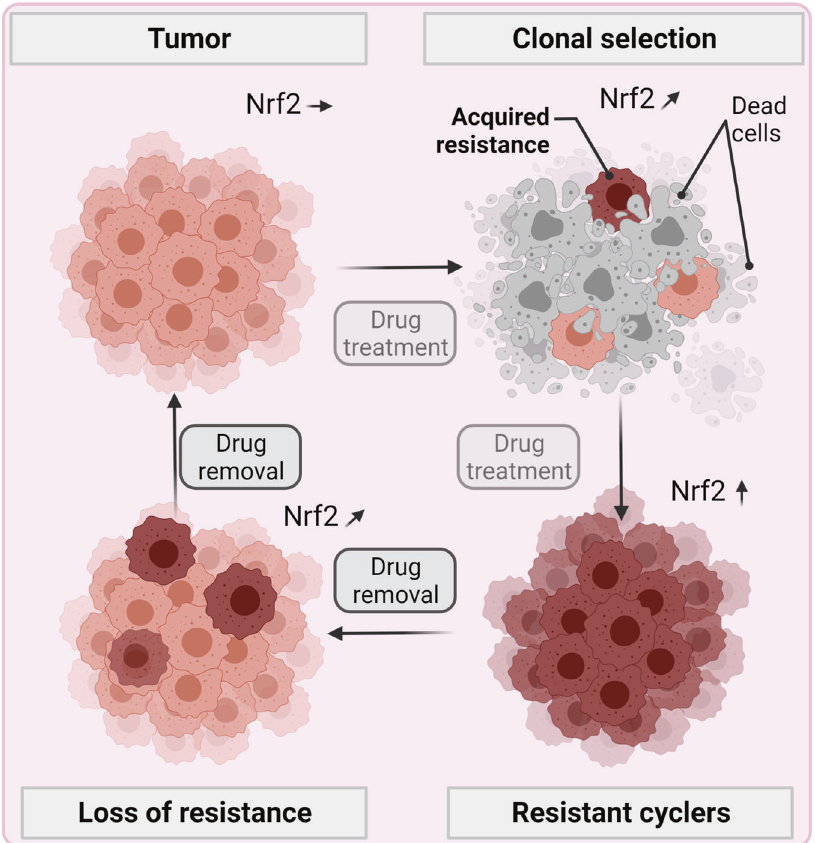
Fig. 1 Cycling persisters upon TKI drug pressure. In unchallenged tumor cells with physiological Nrf2 levels, drug exposure leads to a clonal selection of cells with acquired drug resistance characterized by supraphysiological Nrf2 levels. Only cells with high antioxidant defense levels can proliferation while drug-resistant cells with lower levels do not. Nrf2 and antioxidant defense levels ceased after drug removal, ultimately resembling tumor cells before the initial drug challenge. Hence, drug sensitivity and resistance are dynamic cellular states controlled by a set of antioxidant defense response genes rather than separate entities a priori. Created with